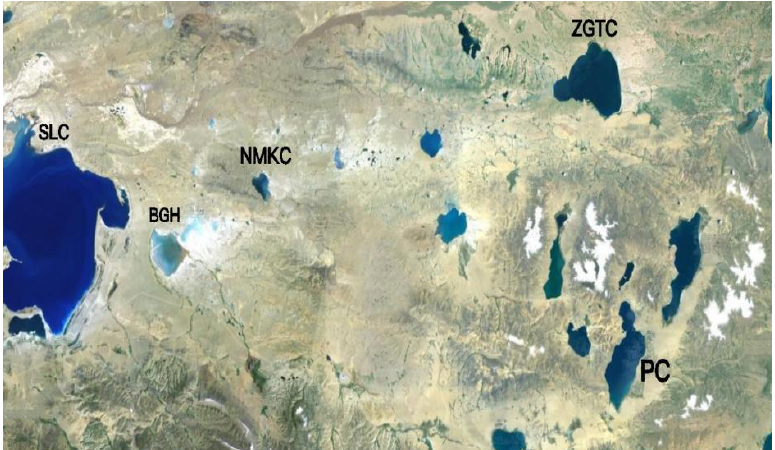
Figure 1. Sampling points of each lake. SLC, Selincuo Lake; BGH, Bangehu Lake. The D. tibetana used in the experiment were collected from NMKC, PC, and ZGTC in Tibet in October 2018. Daphniopsis tibetana were brought back to the laboratory and domesticated in diluted seawater with a salinity of 15–16 ppt at 15 ± 0.5 ◦ C and fed with Chlorella pyrenoidosa . To avoid the negative impact of individual differences on the experiment, observation of life history started with the larval-stage of D. tibetana of the same maternal line. We isolated one gravid mother prior to the experiment and only used its offspring. For the process of domestication, pure water was added to sterilized seawater to adjust the salinity, and the seawater was diluted to 15~16 as culture water. The room temperature was controlled by air conditioning, and the temperature was adjusted to 15 ± 0.5 ◦ C. The Chlorella pyrenoidesa was used as feed with one daily feeding. The culture medium was not replaced during the observation